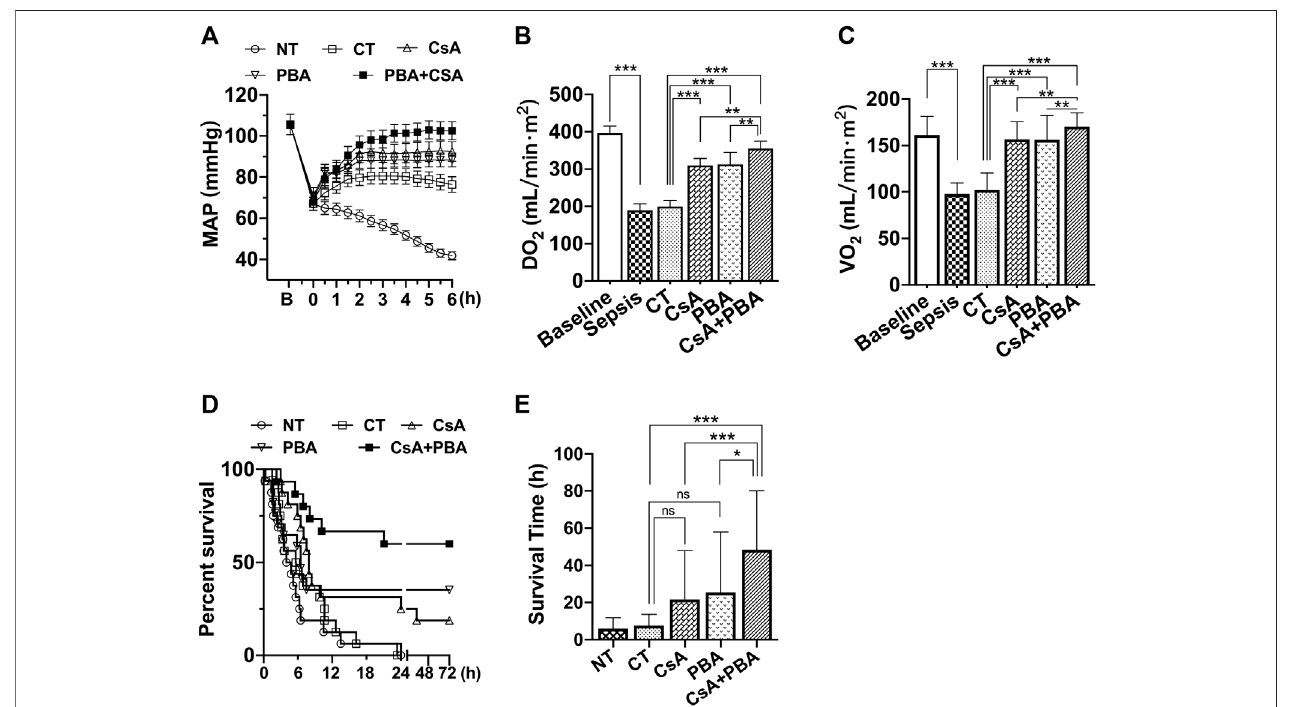
FIGURE1| SynergeticeffectofPBAandCsAonimprovingsurvivalandoxygendeliveryinCLP-inducedsepticshockrats. (A) ,meanarterialpressure(MAP)( n (cid:1) 8/ group); (B) ,oxygendelivery(DO 2 )( n (cid:1) 8/group); (C) ,oxygenutilization(VO 2 )( n (cid:1) 8/group); (D) ,survivalrateandsurvivaltime( n (cid:1) 16/group).CsA,cyclosporineA;PBA,4- phenylbutyrate; CT, conventional treatment; NT, no treatment. * p < 0.05, ** p < 0.01, *** p <